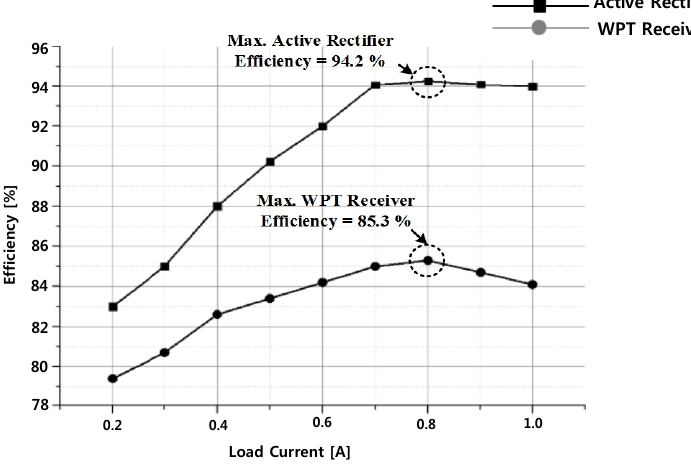
Figure 14. Measured PCE of the active rectifier and wireless power receiver. Table 1. Performance comparison with prior works